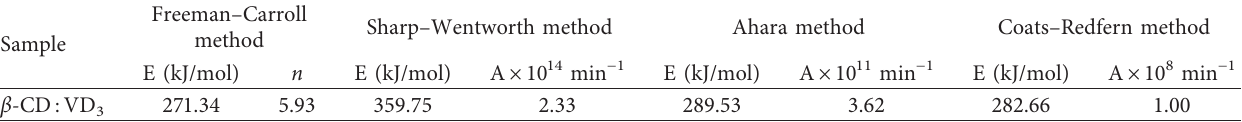
Table 2: 1 H and 13 C NMR chemical shifts in a free state and as a part of the β -CD: VD